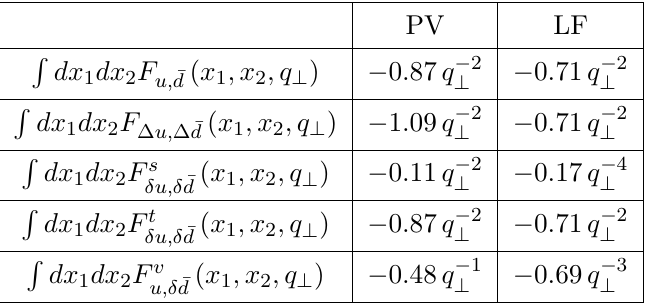
Table 3 . Behavior of the function R dx 1 dx 2 F a